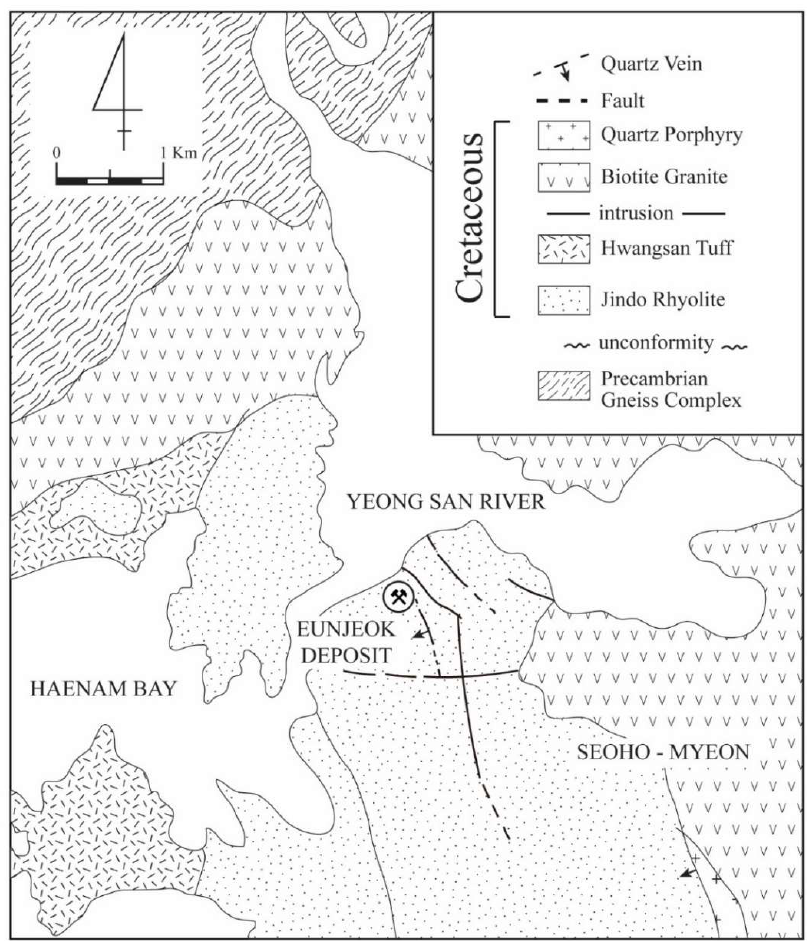
Figure 3. Local geological map of the Eunjeok gold–silver deposit area.